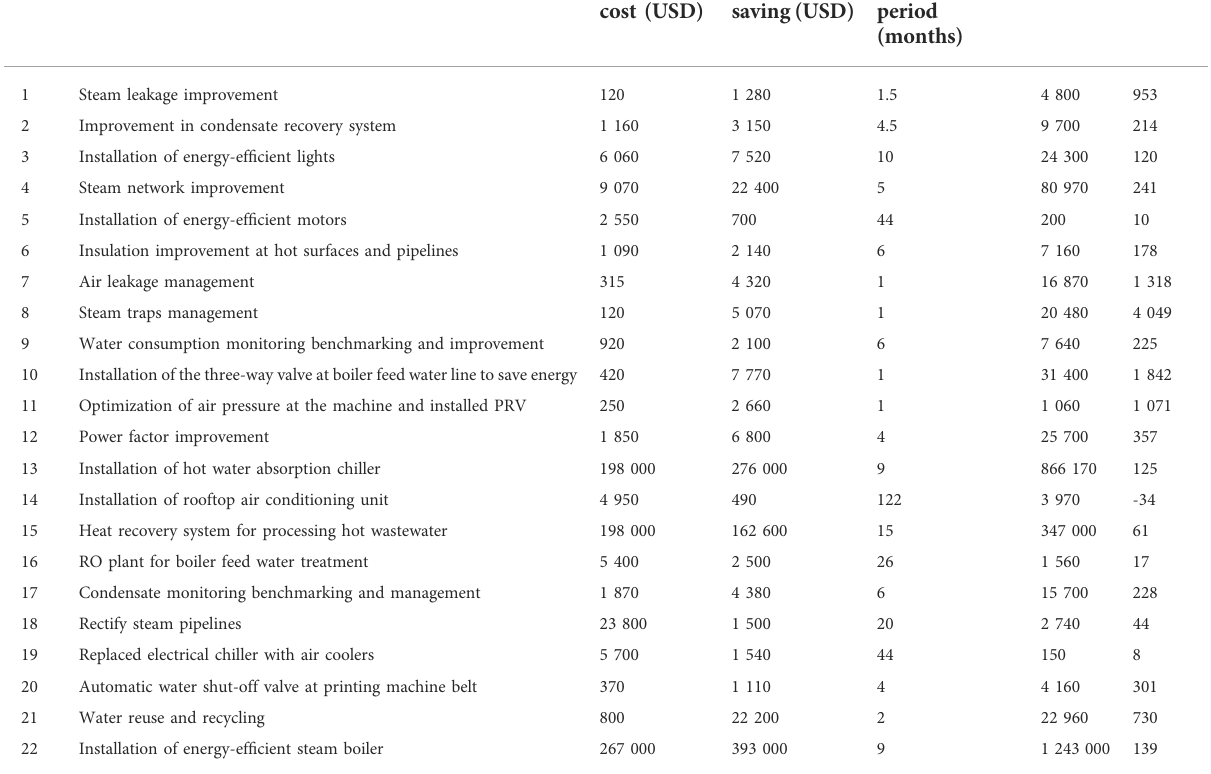
TABLE 8 Financial analysis of the implemented smart environmental management practices (SEMPs). S. no.